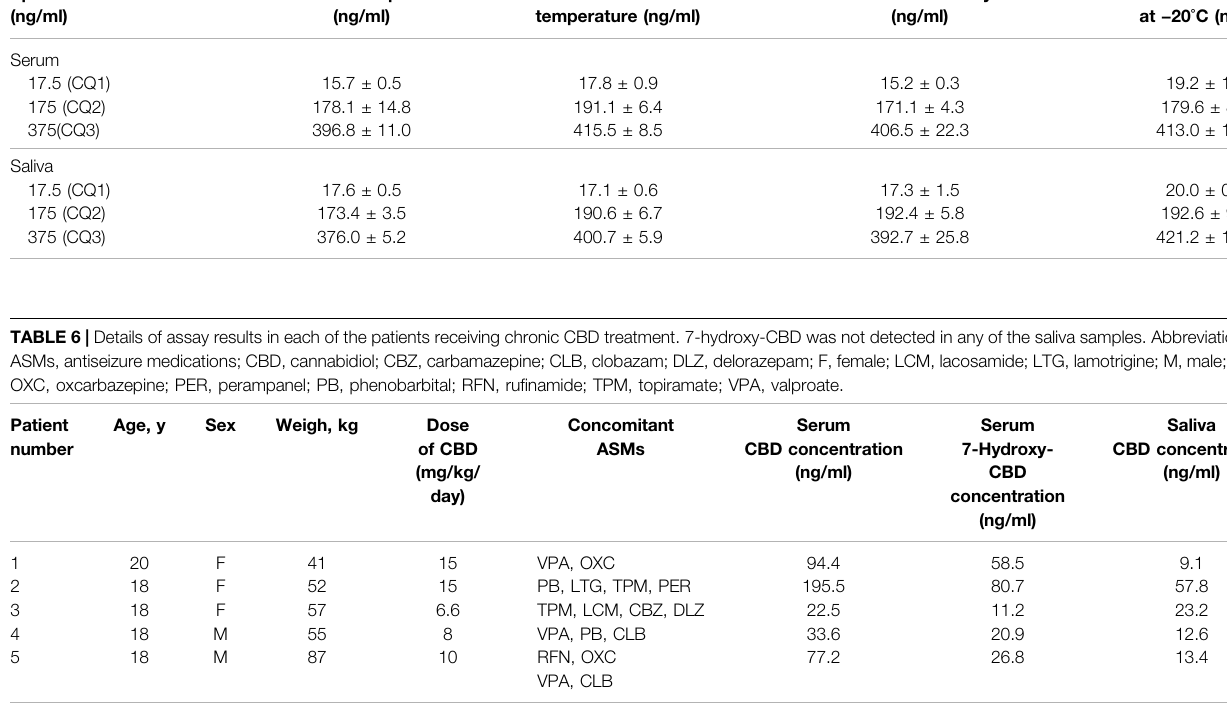
TABLE 5 | Stability of 7-hydroxy-CBD in human serum and saliva under different storage conditions. Spiked concentration (ng/ml) Serum 17.5 (CQ1)